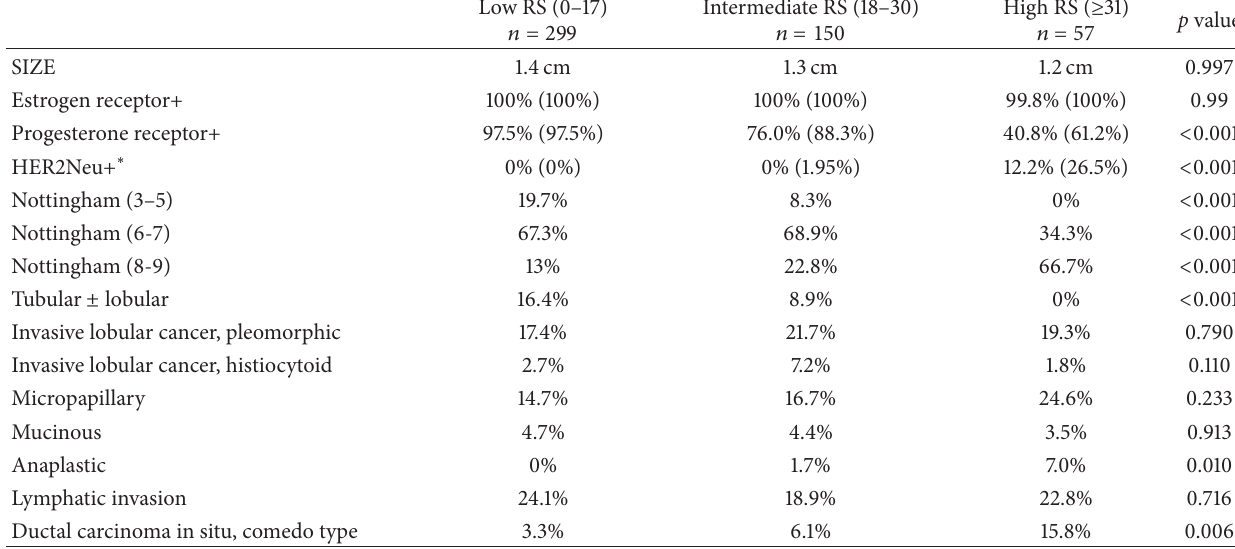
Table 1: Summary of pathology findings correlated with recurrence score